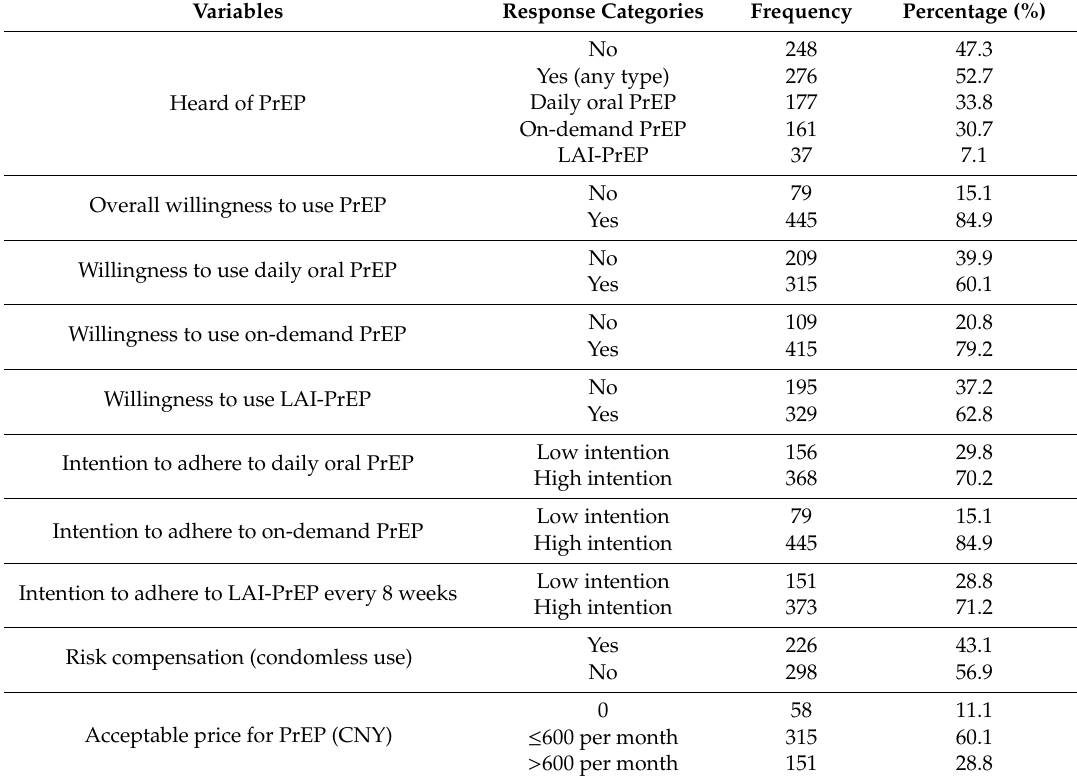
Table 2. Descriptive statistics of pre-exposure prophylaxis (PrEP)-related variables ( N =